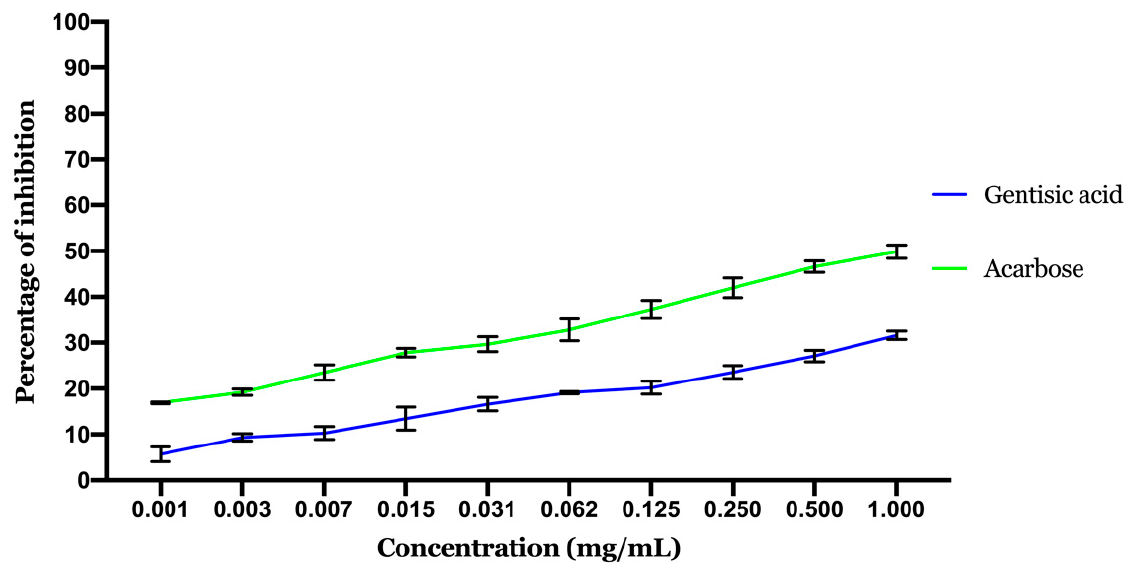
Figure 7. Results of α -amylase inhibitory activity. Values are expressed as mean ± standard deviation (SD, n = 3).